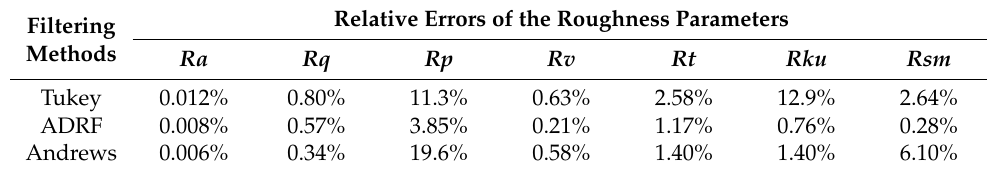
Table 7. Relative errors of roughness parameters obtained by different filtering methods.